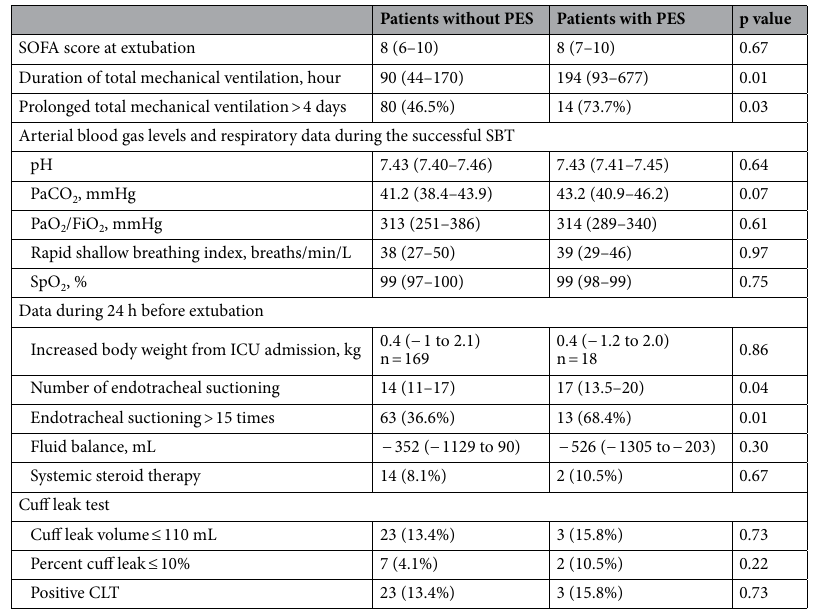
Table 4. Data at extubation among the patients with or without PES. Data are presented as median and interquartile range or number (percentage). The positive CLT was defined as the cuff leak volume ≤ 110 mL and/or the percent cuff leak ≤ 10% PES post-extubation stridor, SOFA sequential organ failure assessment, SBT spontaneous breathing trial, CLT cuff leak test.